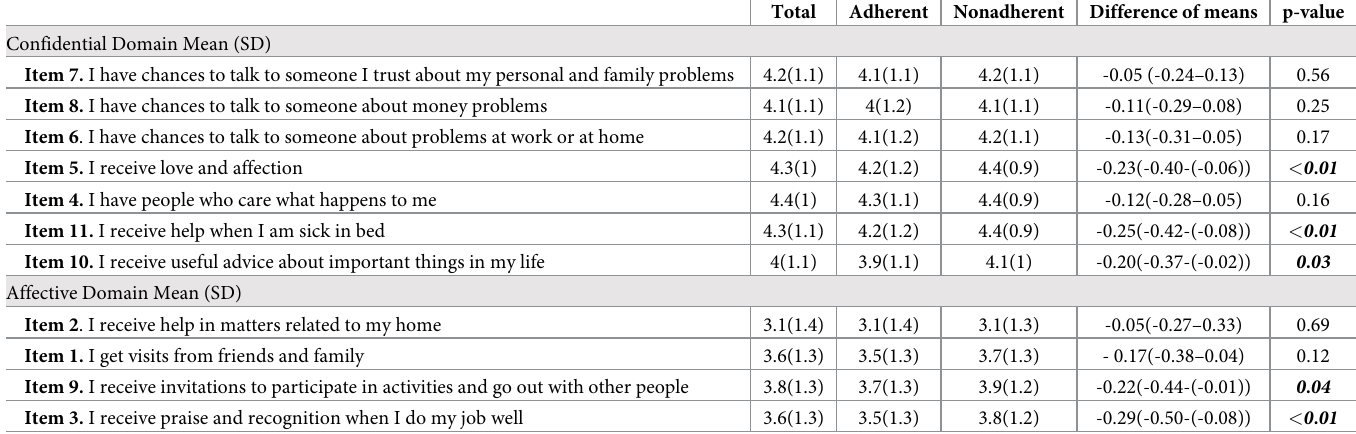
Table 2. Distribution of the DUFSS questionnaire items according to adherence. Order of items following Ayala´s